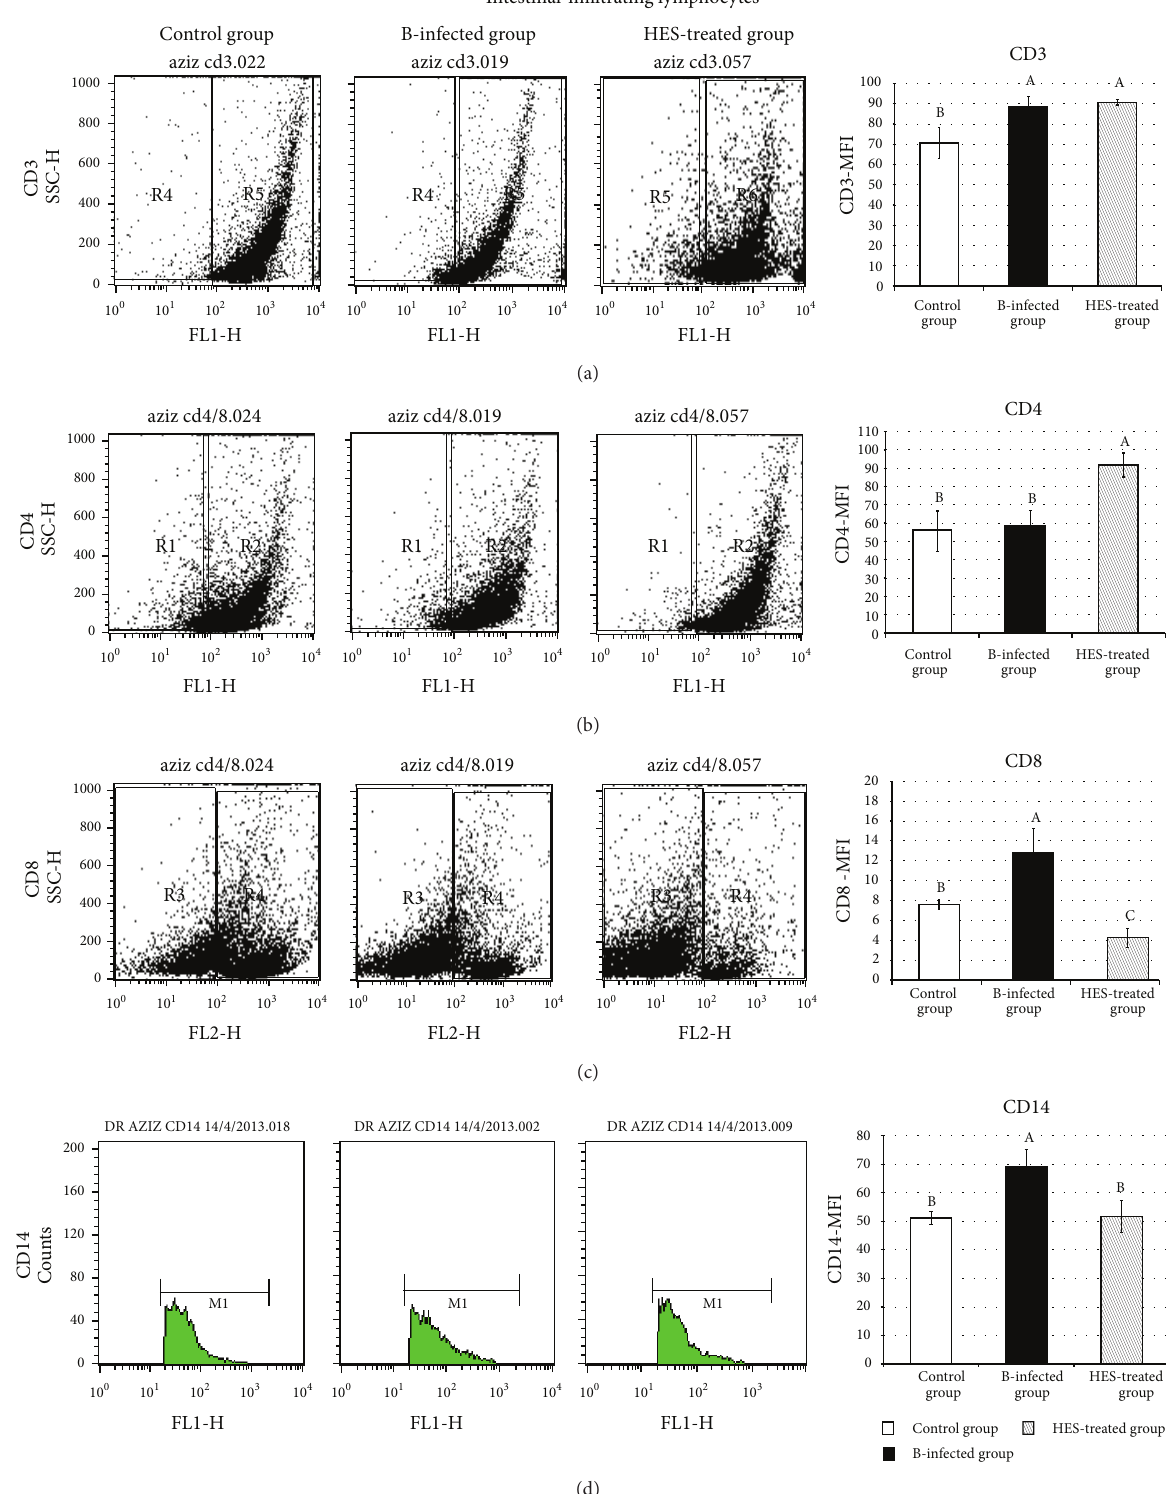
Figure 3: Representative dot plots of FACS analysis showing changes in Mean Fluorescence Index (MFI) of CD3 + , CD4 + , and CD8 +